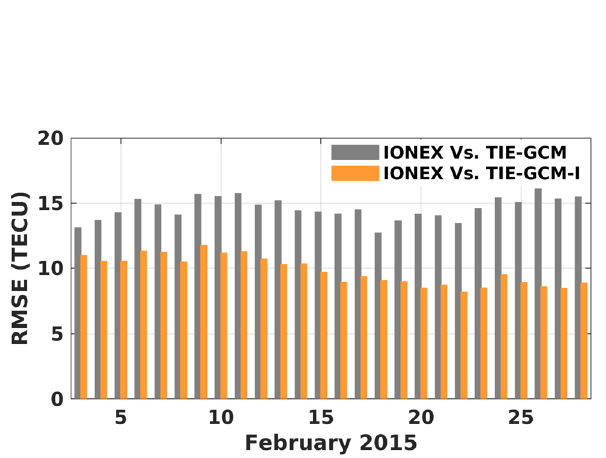
Figure 13. A comparison between the RMSE of TEC estimates during February 2015. Here, TEC estimates in the forecasting mode of the original TIE-GCM and TIE-GCM-I models are compared with the IONEX final TEC product from IGS. The plot was generated using MATLAB (version R2021a, https:// www. mathw orks.